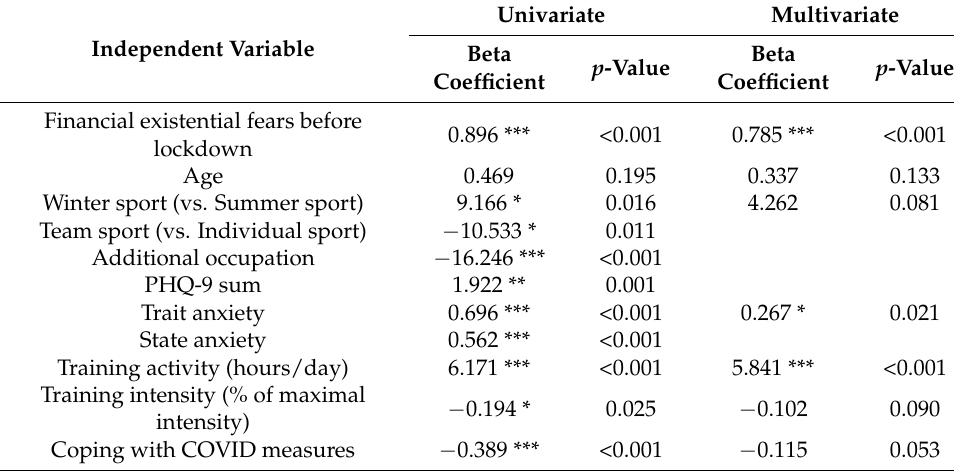
Table 3. Multivariate regression of financial existential